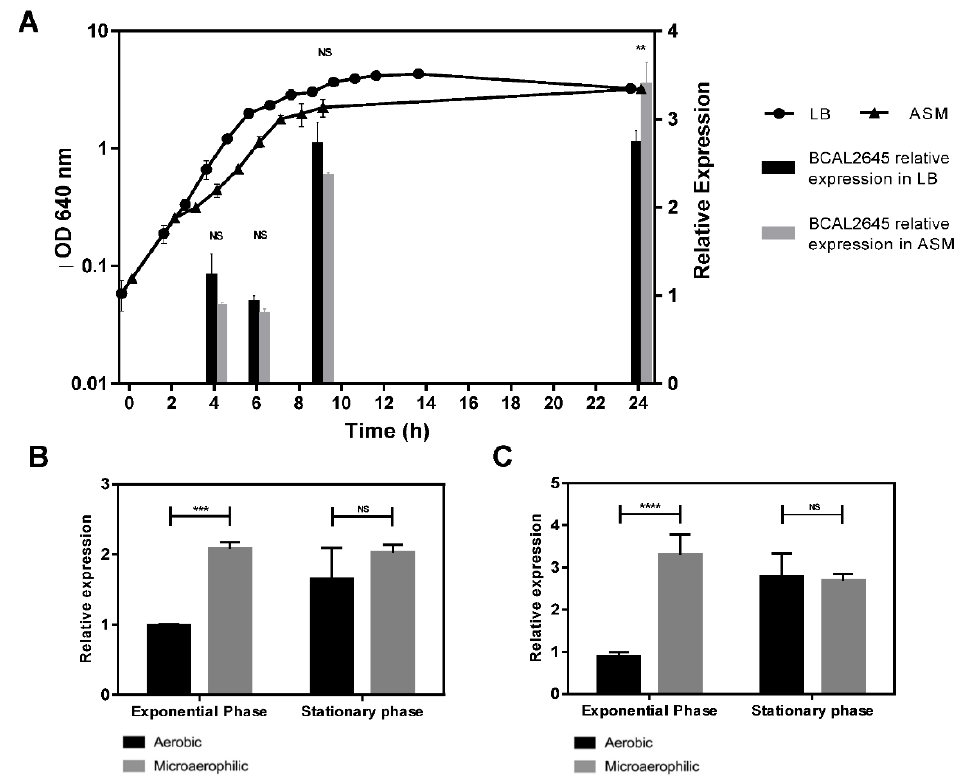
Figure 2. Expression patterns of the BCAL2645 protein in B. cenocepacia K56-2. ( A ) Growth curve of B. cenocepacia K56-2 in LB and ASM medium with BCAL2645 protein expression levels at the early exponential, exponential, early stationary and late stationary phases, corresponding respectively, to 4, 6, 9 and 24 h of cultivation. The intensity of total proteins and of the bands probed with the anti-BCAL2645 antibody were detected and quantified. Data normalization was performed relative to total proteins for each sample. Samples harvested at 6 h were used as the internal standard reference to determine the relative protein expression levels. Relative amount of BCAL2645 protein in B. cenocepacia cultures grown in LB ( B ) or ASM ( C ) medium when grown under microaerophilic or aerobic conditions. Growth experiments were performed in the wells of polystyrene microtiter plates with constant agitation. Microaerophilic conditions were obtained using the CampyGenTM Compact Sachet in OxoidTM Compact Plastic Pouch. Exponential phase was considered when an OD 640 of 1 was obtained. The stationary phase was reached after 24 h of growth. The value of exponential phase in aerobic conditions was used as the internal standard reference to determine the relative protein levels. Results are representative of three independent experiments. Error bars indicate standard deviation. Statistical analysis was performed by comparison with the 4 h (****, p < 0.00001, ***, p < 0.001, NS, non-significant).